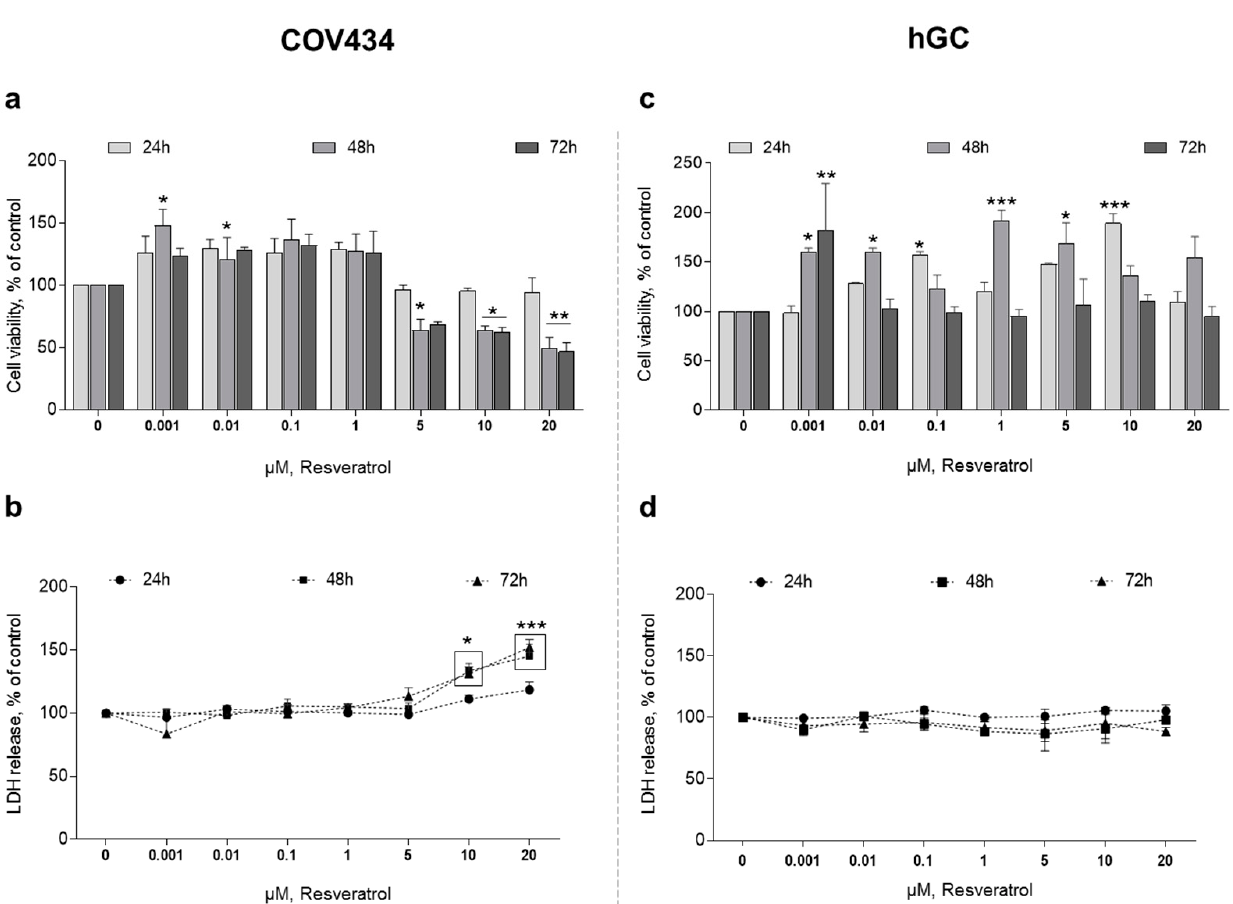
Figure 1. Resveratrol (RES) effect on COV434 and human granulosa cell (hGC) viability. MTT( a , c ) and LDH ( b , d ) assays after treatment with different concentrations of RES (0.001–20 µ M) at 24, 48, and 72 h. Results are related to the control and expressed as mean ± SEM of at least five independent experiments performed in triplicate. Significant differences between control and treated cells are indicated as * ( p ˂ 0.05), ** ( p ˂ 0.01) and **** ( p ˂ 0.0001).